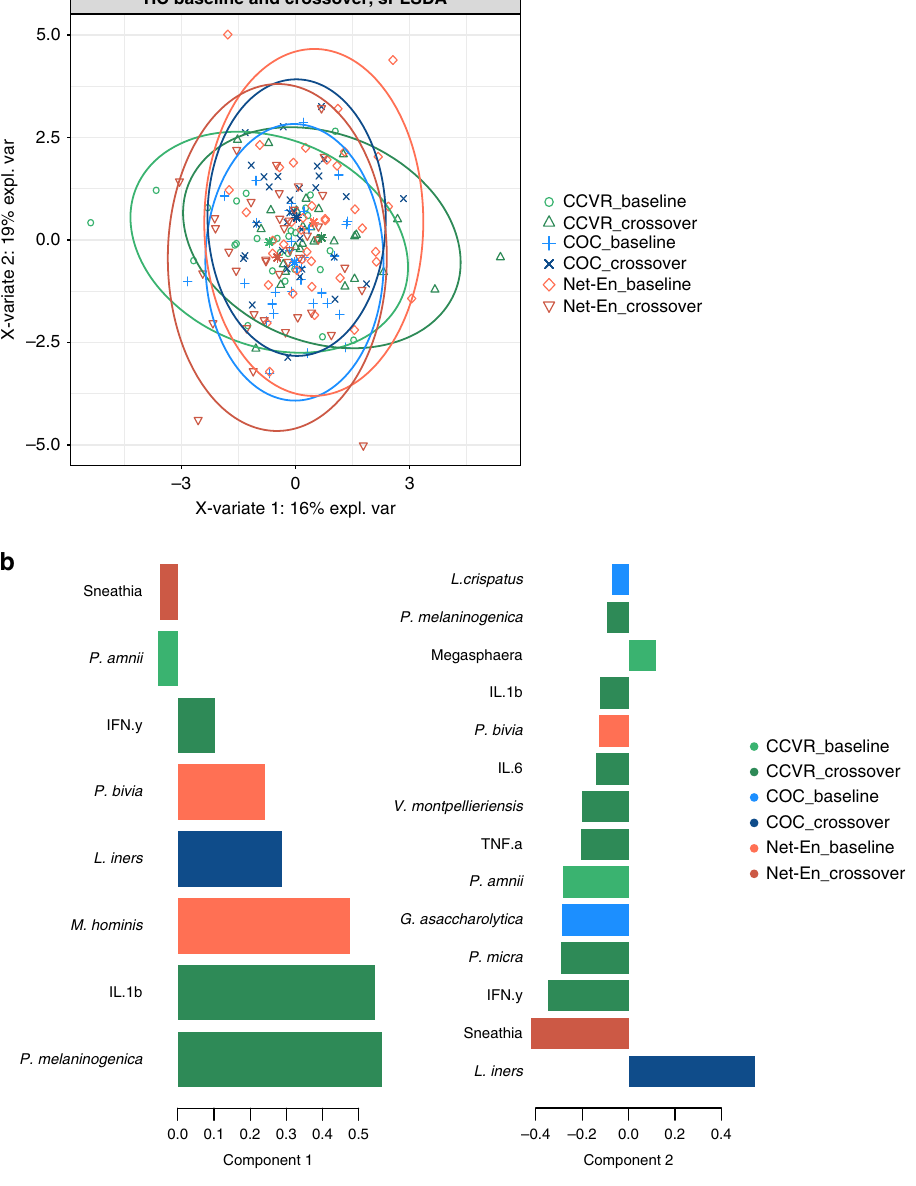
Fig. 4 Effect of hormonal contraception on bacterial taxa and cervicovaginal cytokines implicated in HIV risk. a A multilevel sparse partial least-squares discriminant analysis (sPLSDA) of cytokines and bacterial taxa associated with HIV grouped before (baseline) and after (crossover) use of COC, Net-En, or CCVR, respectively. b Barplot showing the loadings of components 1 and 2 from the sPLSDA analysis. The absolute value is an indication of the importance of the bacteria or cytokine, while the sign indicates positive/negative correlations between the variables. CCVR: combined contraceptive vaginal ring, COC: combined oral contraceptives. Source data are provided as a Source Data fi key vaginal bacteria (i.e., Lactobacillus species, Gardnerella vagi- nalis , and Atopobium vaginae ) in 120 Rwandan women 44 . The presence and concentrations of Lactobacillus species in vaginal fl uid increased signi fi cantly, whereas the concentration of G . vaginalis and presence of A . vaginae decreased after initiation of CCVR, suggesting that the CCVR favored healthy vaginal microbe colonization over BV-associated anaerobes 44 . In our present study, measuring relative abundance rather than absolute quantities of bacteria, we observed the opposite. It is likely that both the relative abundance and the absolute concentrations of key bacteria are important factors for optimal vaginal health. Of